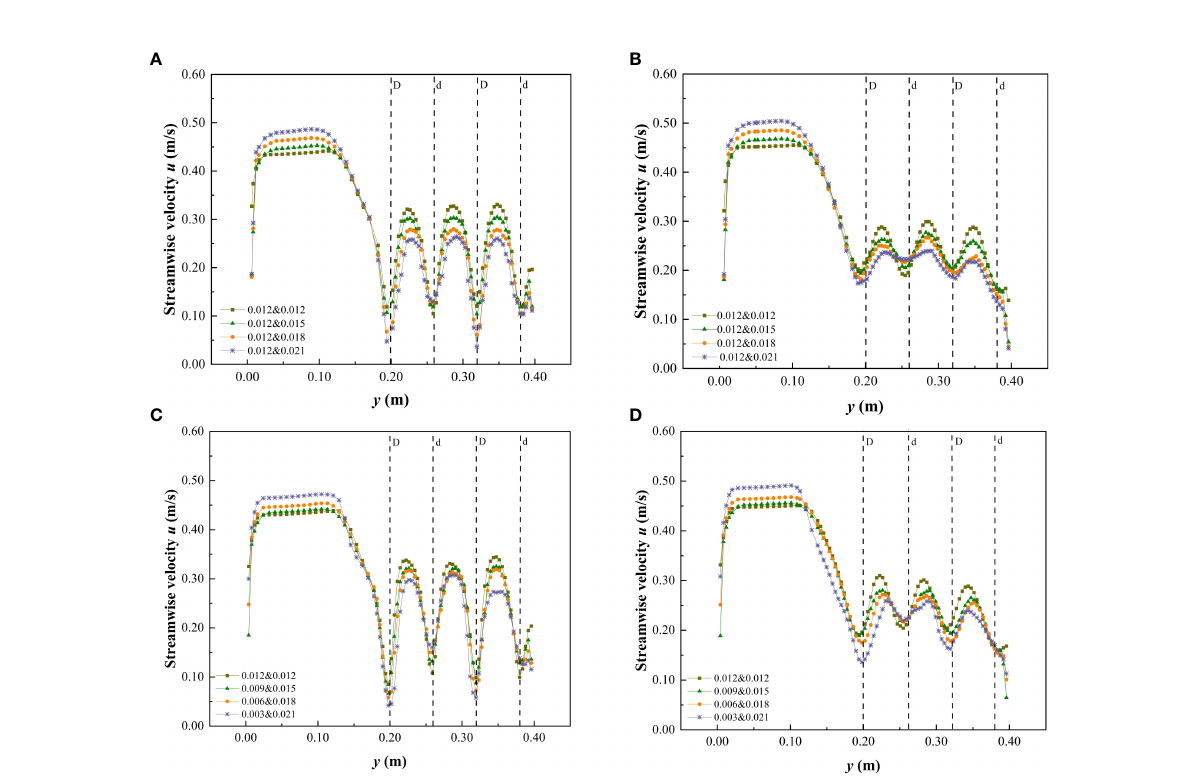
FIGURE 6 Variation of streamwise velocity in cross-section when h is 0.06 m under the non-submerged condition. (A) C 2 , vegetation combination distribution, (B) C 3 , vegetation combination distribution, (C) C 2 , vegetation discrete distribution, (D) C 3 , vegetation discrete